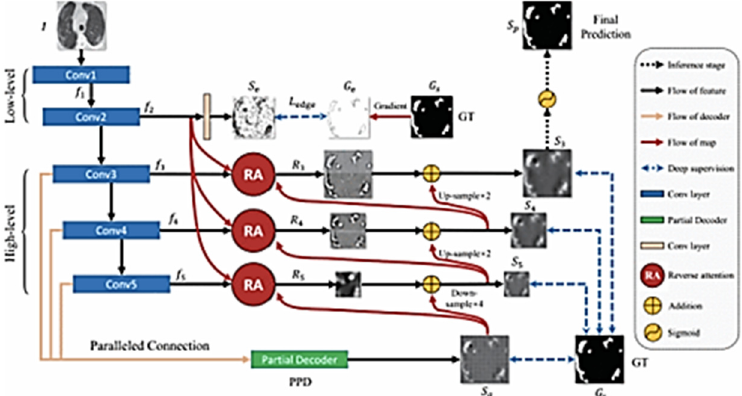
Figure 7. Infection Network (Inf-Net) for segmentation [73].